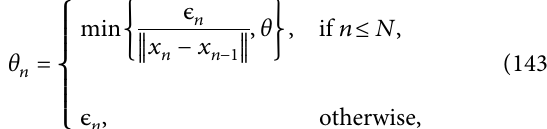
Figure 2: The Cauchy error plotting number of iterations for different parameters ε